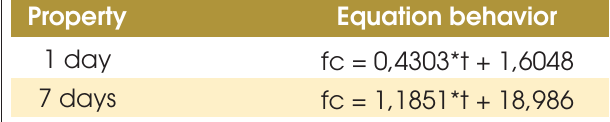
Table 8 – Behavioral equations relating the compressive strength and curing temperature Property